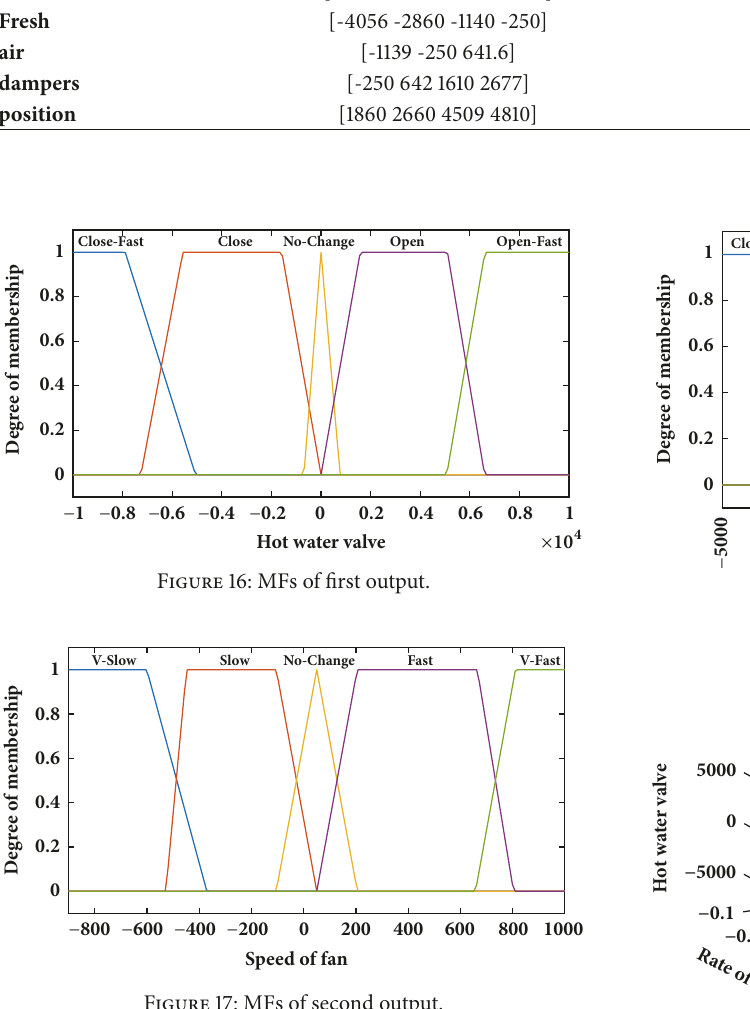
Figure 17: MFs of second output.